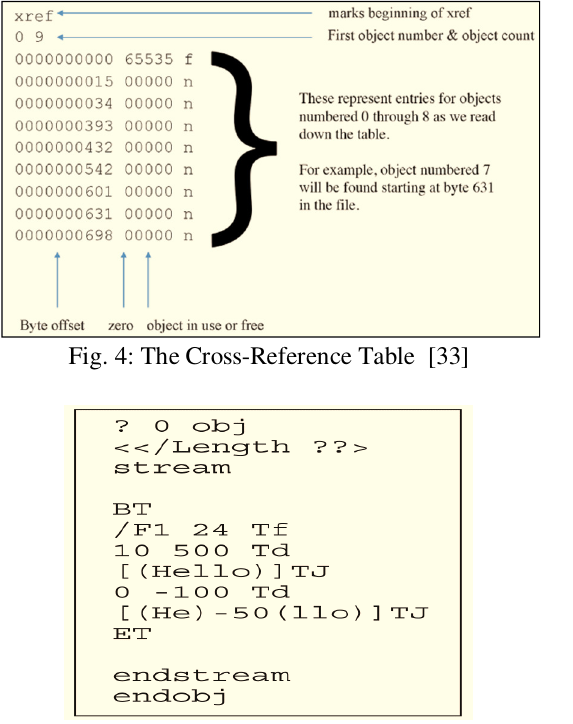
Fig. 5: A PDF file object example